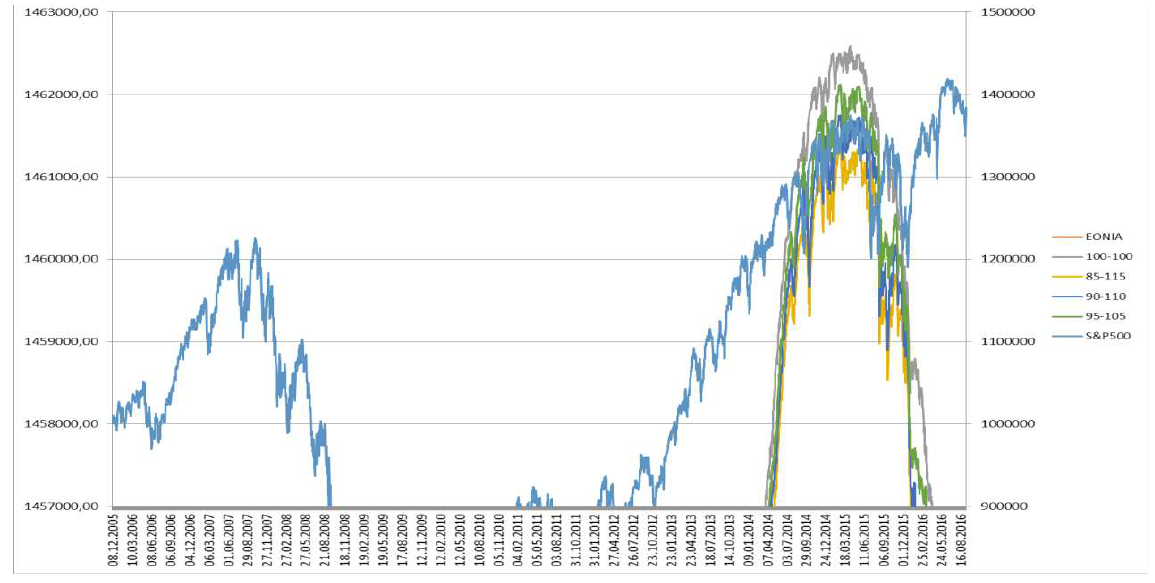
Figure 6. Implied volatility (VIX) scenario for all coefficients